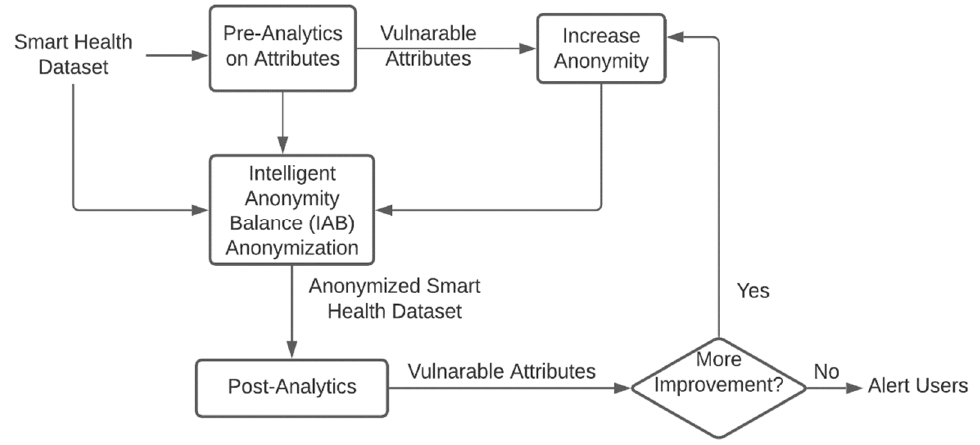
Figure 1. Overview of the Proposed Multi-faced Anonymity Analytical Approach.